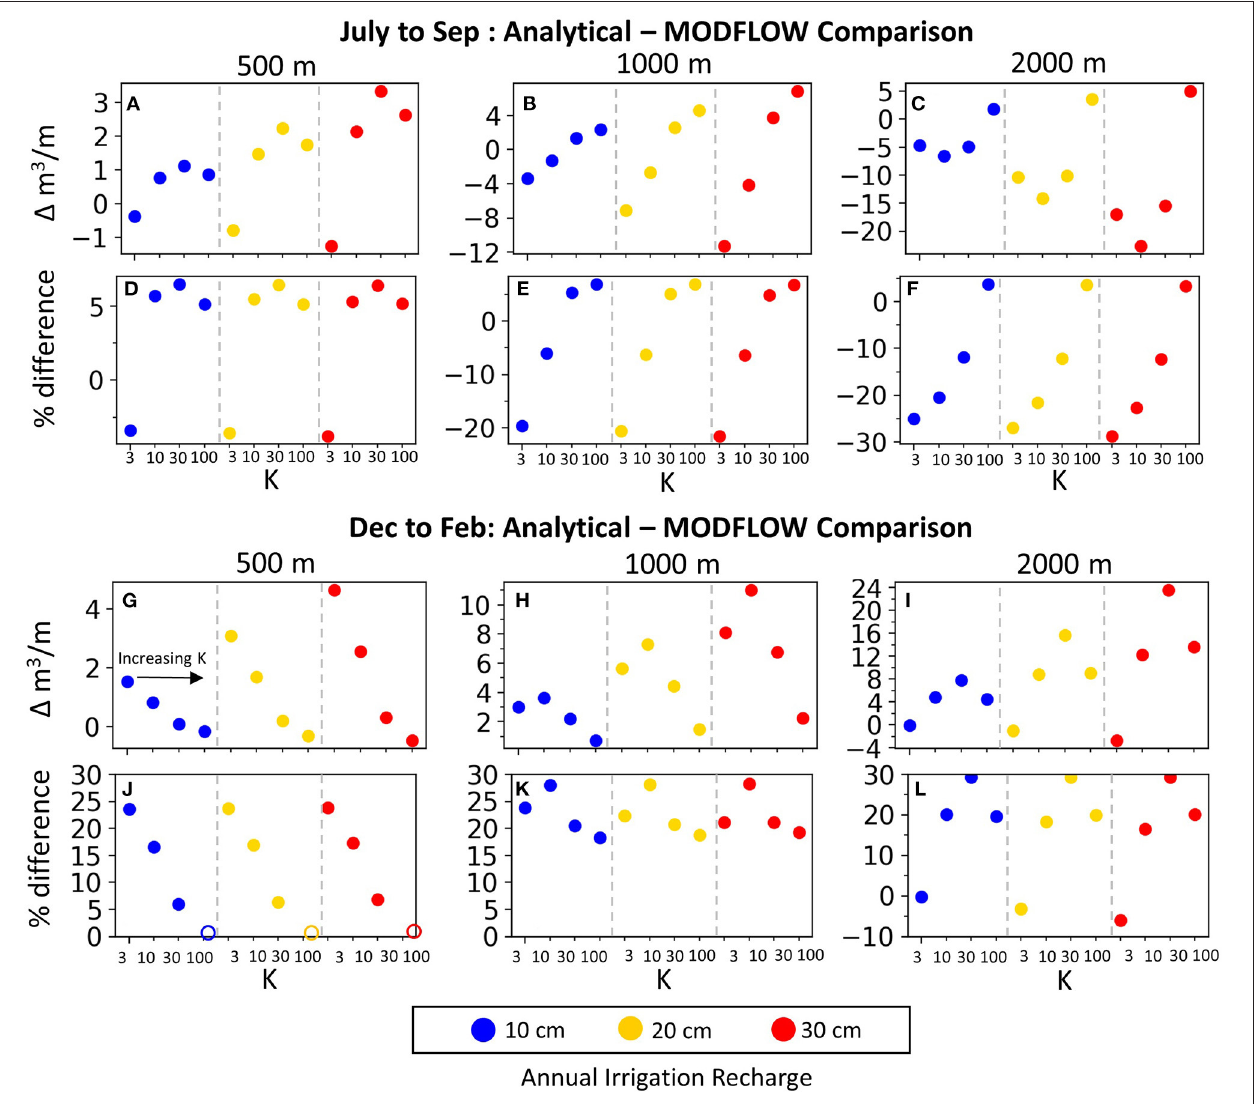
FIGURE 11 | Assessment of analytical return flows against modeled return flows for July-September (A–F) and December-February (G–L) . Within each subplot, each irrigation recharge value is grouped by annual irrigation recharge (indicated by different colors) and aquifer K, as annotated in (G) and indicated on the x-axis. The open circles in (J) are because the actual percentage difference is off of the plot ( − 700%), but because the absolute difference for these three cases is very close to zero (G) , we plotted the % difference near zero so the other values in (J) would be